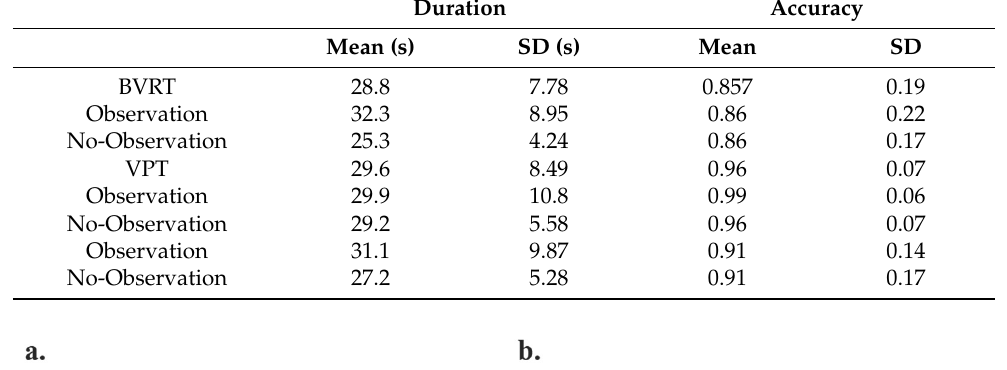
Table 2. Type III analysis of variance table with Satterthwaite’s method of condition on duration. A significant difference between task durations was observed when comparing participants who were observed with those that were not observed. No significant effect of task format was observed. ** indicates p < 0.01. Definitions. Sum of Sq: Sum of Squares. Mean sq: Mean Squares, NumDF: Nu- merator, Degrees of Freedom. DenDF: Denominator, Degrees of Freedom. Sum Sq.